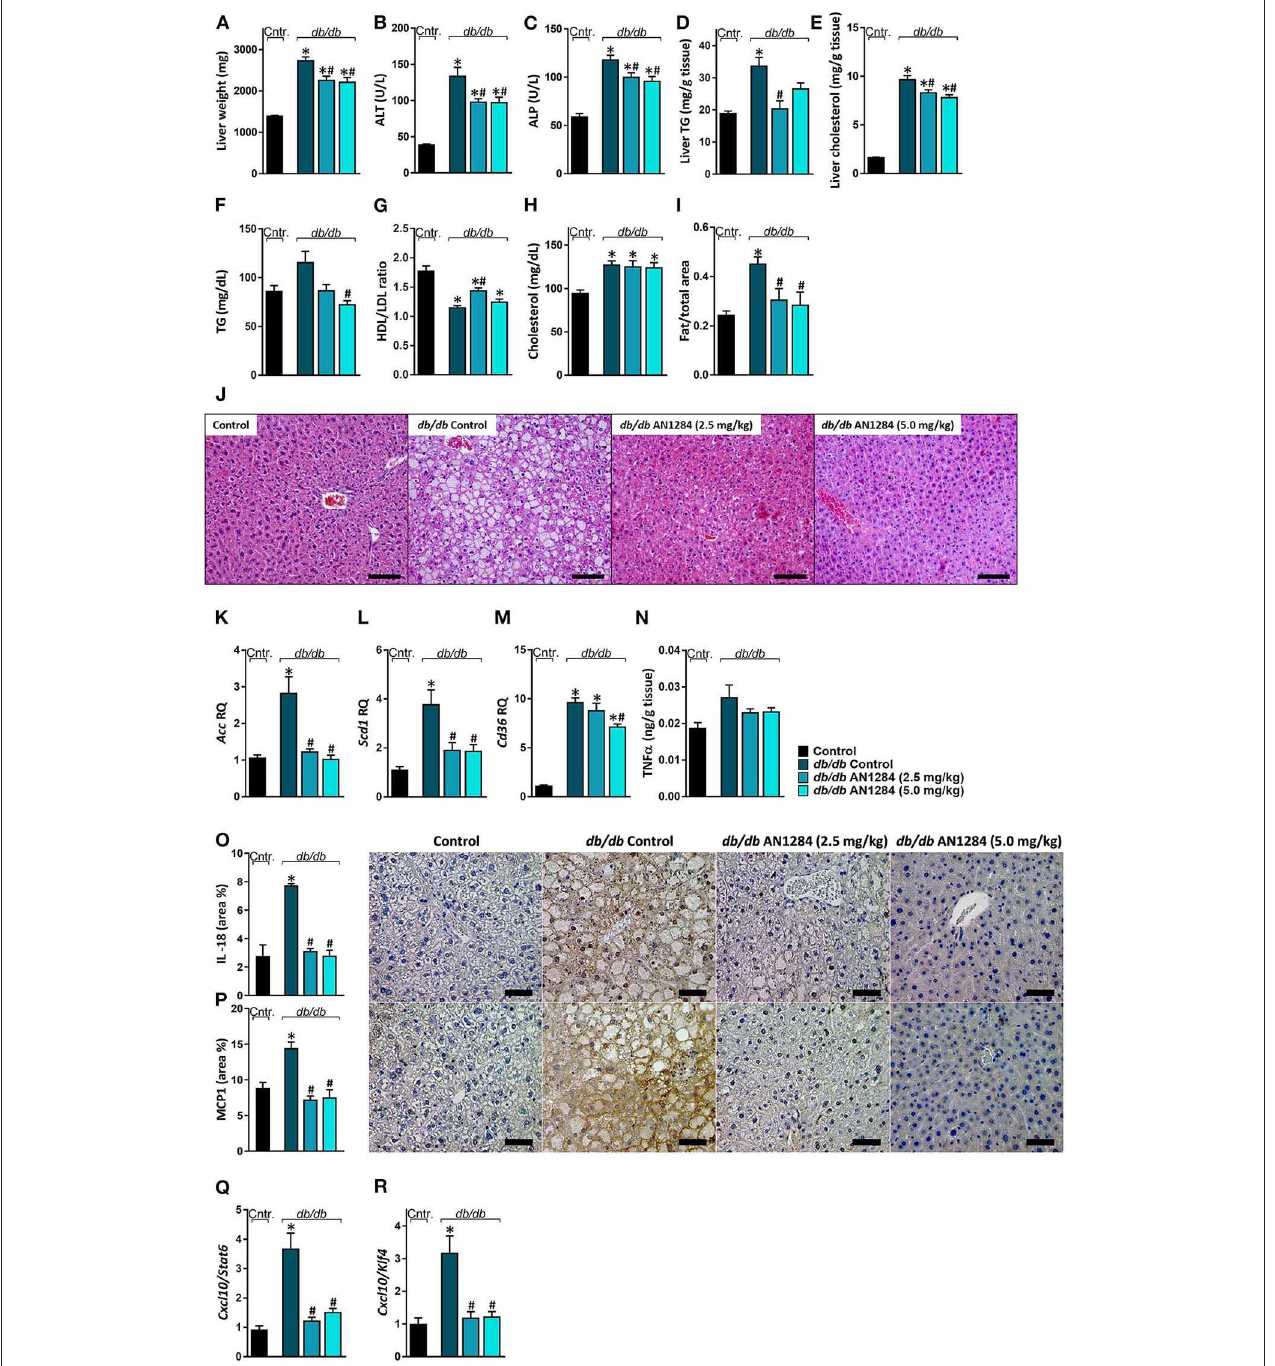
FIGURE 6 | AN1284 ameliorates hepatic steatosis and inflammation in db/db mice. The db/db mice exhibit increased liver weight (A) , serum ALT (B) , and ALP (C) levels as well as hepatic triglyceride and cholesterol contents (D,E) . These parameters were prevented or ameliorated by AN1284 treatment. AN1284-treated mice also displayed decreased serum triglyceride levels (F) , increased HDL/LDL cholesterol ratio (G) , without an effect on total cholesterol levels (H) . Quantification of hepatic fat content revealed an increase in db/db animals, which was normalized by AN1284 treatment (I) . Representative liver images demonstrating macrovesicular steatosis in H&E-stained sections from db/db mice. Scale bar, 100 µ m (J) . The elevated hepatic mRNA expression levels of Acc (K) , Scd1 (L) , and Cd36 (M) in db/db mice were normalized by AN1284 treatment. Insignificant changes in hepatic TNF α protein levels were noted in non-treated and treated mice (N) . Reduced protein expression of IL-18 (O) , and MCP1 (P) in AN1284-treated db/db mice was documented. Scale bar, 50 µ m. M1-to-M2 macrophage marker ratios displayed high content of M1 macrophages in db/db animals, which was diminished by AN1284 treatment (Q,R) . Data represent the mean ± SEM from 8 to 10 mice per group. * P < 0.05 relative to control non-diabetic mice, # P < 0.05 relative to db/db -Veh-treated control mice.